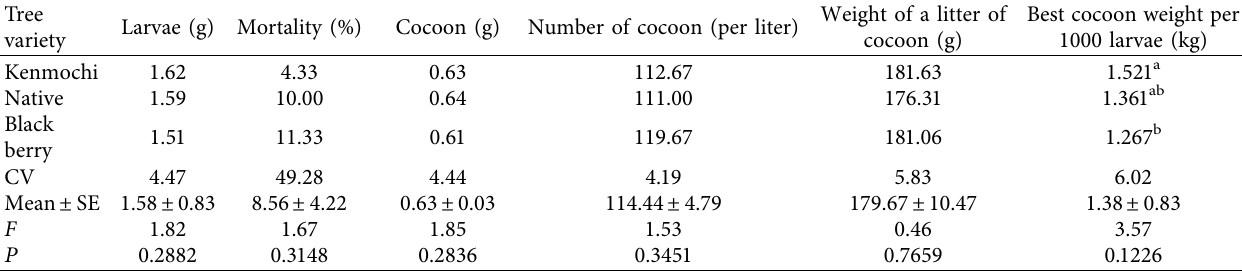
Table 3: Mean of shell parameters and some of the nutritional indices of silkworm hybrid treated with three varieties of mulberry leaves. Tree variety Kenmochi